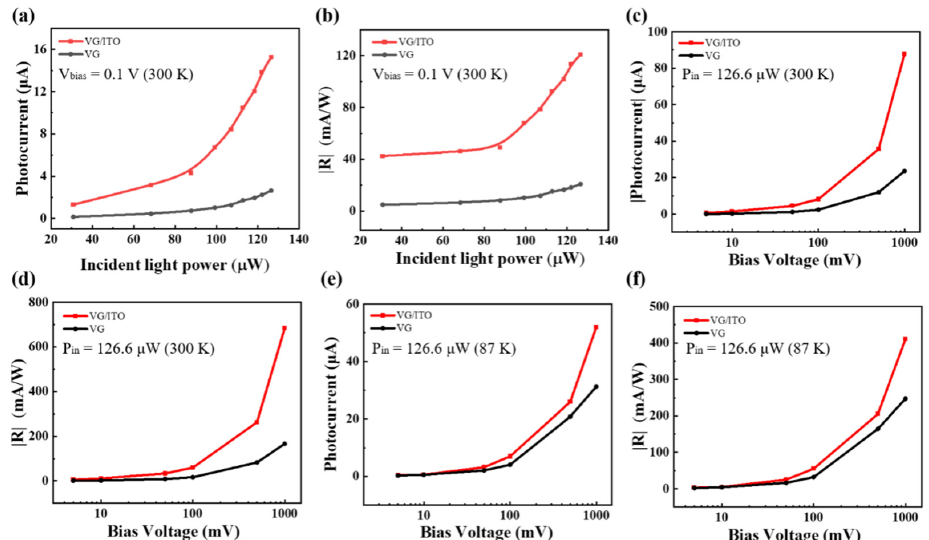
Figure 4. Dependence of photocurrent and photoresponsivity on bias voltage and light power. ( a ) |I ph | as a function P in is shown for a fixed bias voltage (V bias = 0.1 V). ( b ) The dependence of photoresponsivity (|R|) on P in for a fixed bias voltage (V bias = 0.1 V) as shown in ( a ). ( c ) |I ph | at various bias voltages V bias (from 1 to 1000 mV) for a fixed incident laser powers (P in = 126.6 μ W) for the two photodetectors (VG and VG/ITO). ( d ) Photoresponsivity (|R|) as a function of V bias for the three photodetectors. ( e ) |I ph | at various bias voltages V bias (from 1 to 1000 mV) for a fixed incident laser powers (P in = 126.6 µ W) for the two photodetectors (VG and VG/ITO) at low temperature (87 K). ( f ) Photoresponsivity (|R|) as a function of Vbias for the two photodetectors at low temperature (87